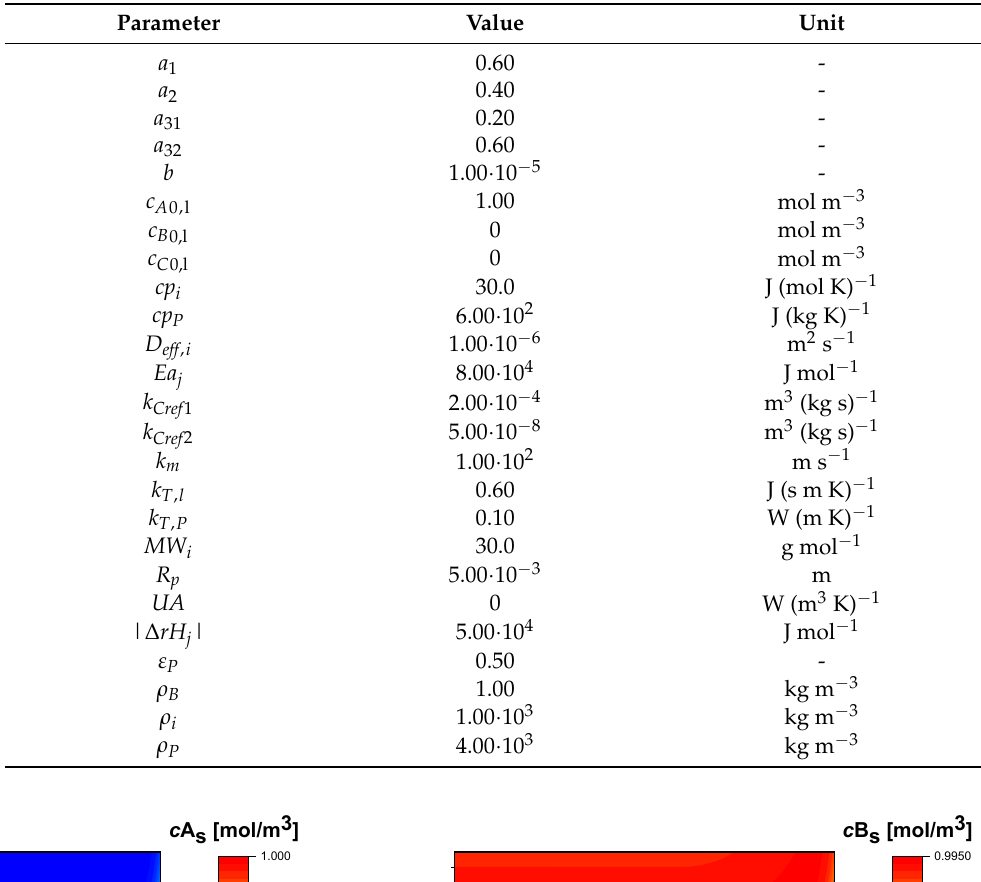
Table 1. Fixed parameters for the liquid and solid phase.